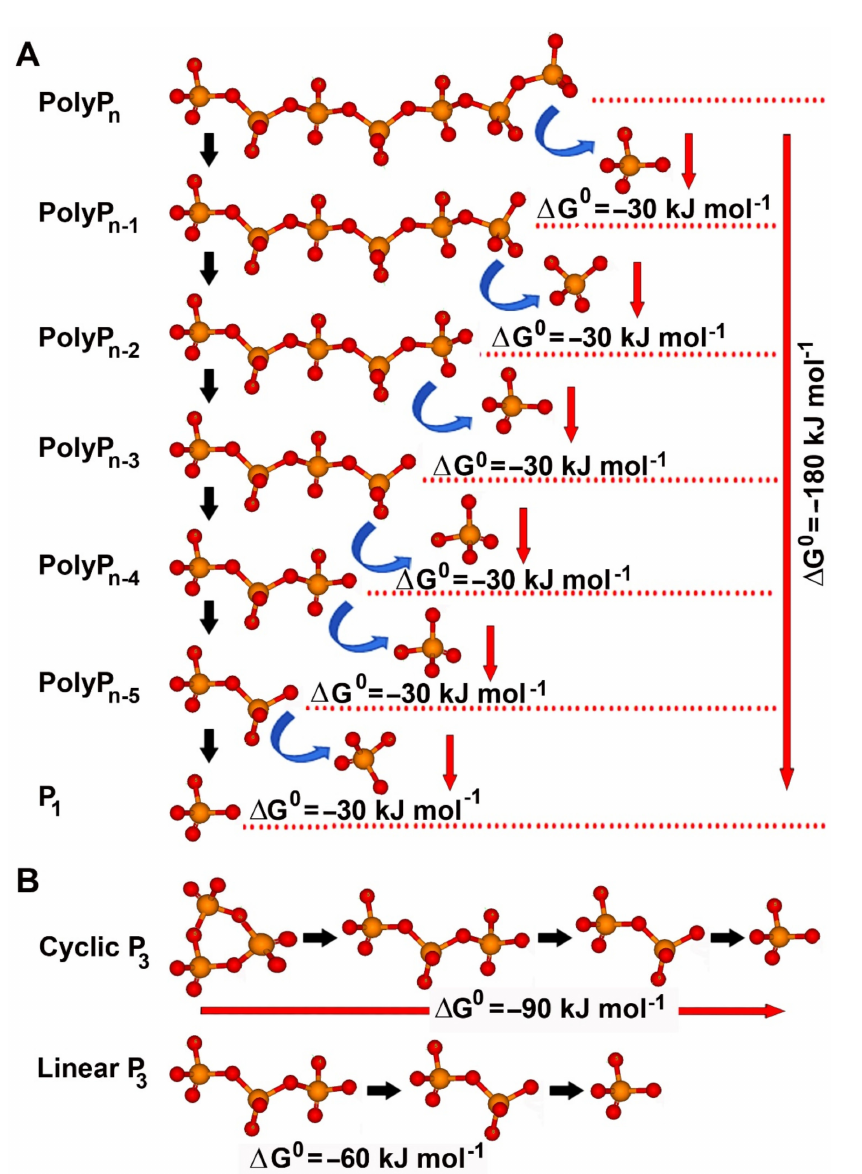
Figure 4. Delivery of metabolic energy during hydrolytic degradation of inorganic polyP. ( A ) Release of Gibb’s free energy ( ∆ G 0 ) during stepwise hydrolysis of the energy-rich phosphoanhydride bonds of linear polyP molecules. During each hydrolytic step, a ∆ G 0 of approximately − 30 kJ · mol − 1 is liberated. ( B ) Short-chain triphosphate (polyP 3 ) can exist either as a linear molecule or in a cyclic form. The cyclic polyP 3 has one phosphoanhydride bond more than the linear molecule and can deliver 50% more energy ( ∆ G 0 = − 90 kJ · mol − 1 ) compared to linear polyP 3 ( ∆ G 0 = − 60 kJ · mol − 1